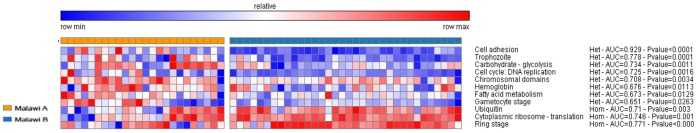
Heatmap showing the enrichment scores from single sample GSEA analysis using our general gene set categories.